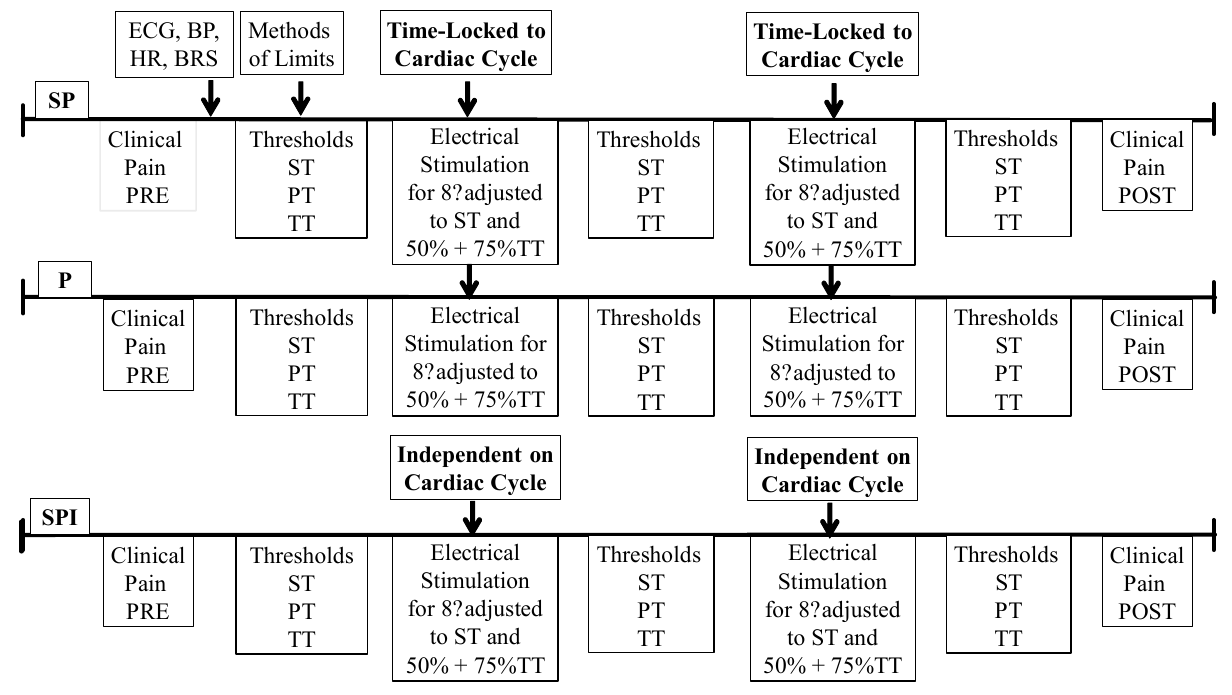
Figure 2. Design of the experiment with the EP, CC1 and CC2 protocols. CC1: control condition 1 protocol. CC2: control condition 2 protocol. EP: experimental protocol. PT: pain threshold. ST: sensory threshold. TT: tolerance